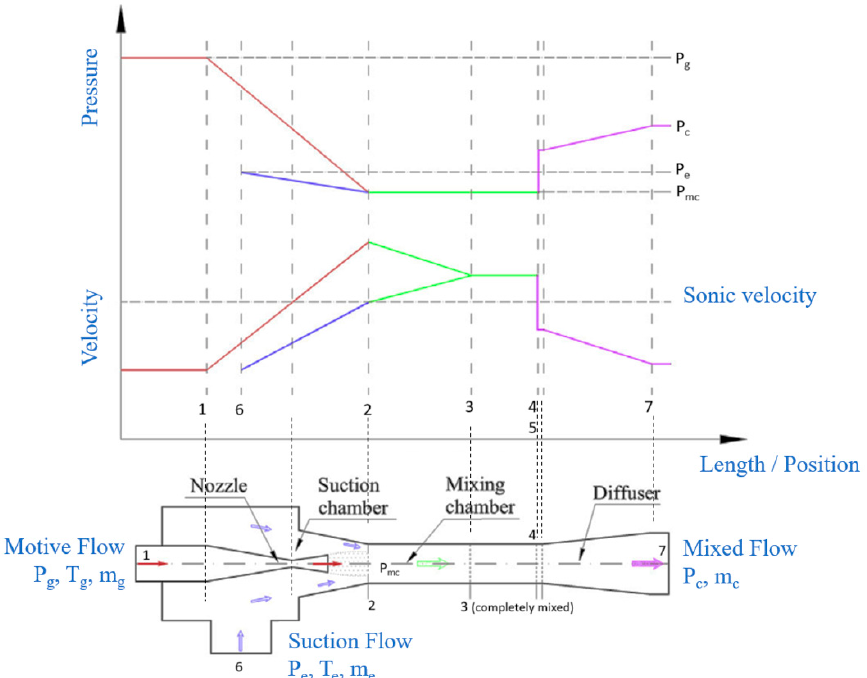
Figure 1. Variation of velocity and pressure at different section of ejector [40].